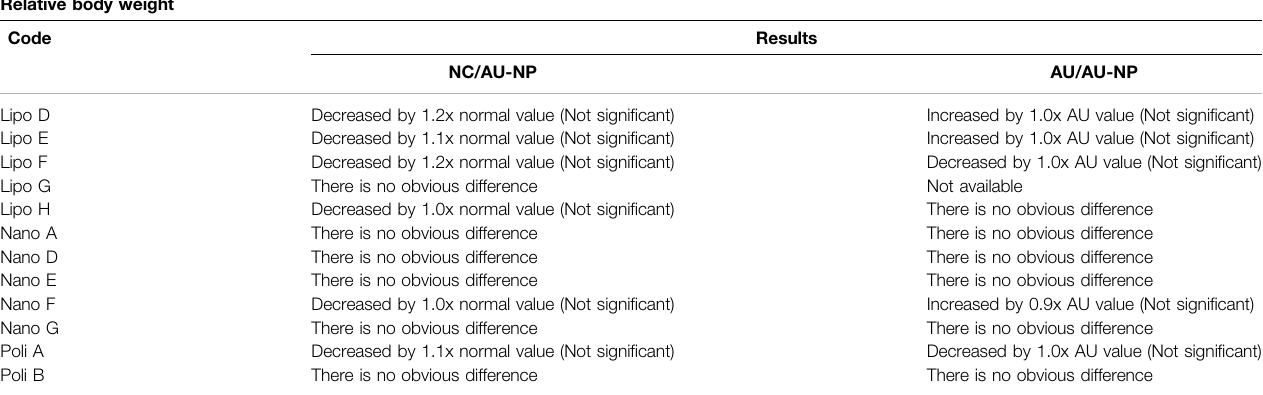
TABLE 7 | Recapitulation of other preclinical